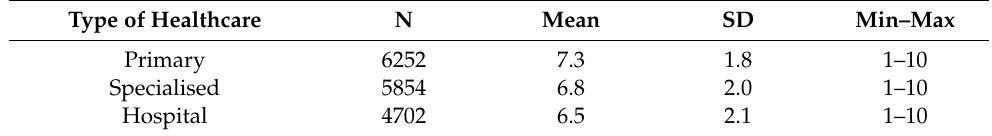
Table 3. Descriptive statistics of the respondents’ self-reported experience with each Spanish health service in 2015.